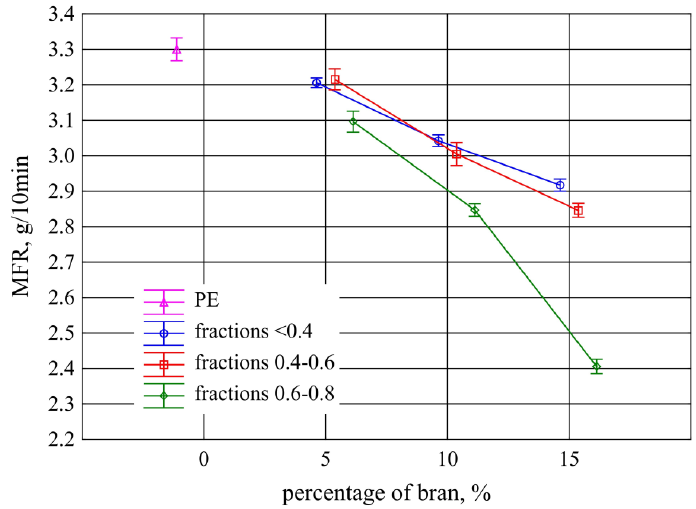
Figure 13. Mass flow rate of samples taken from injection mouldings depending on the mass content and grain size of the introduced bran fraction (average values with standard deviation).